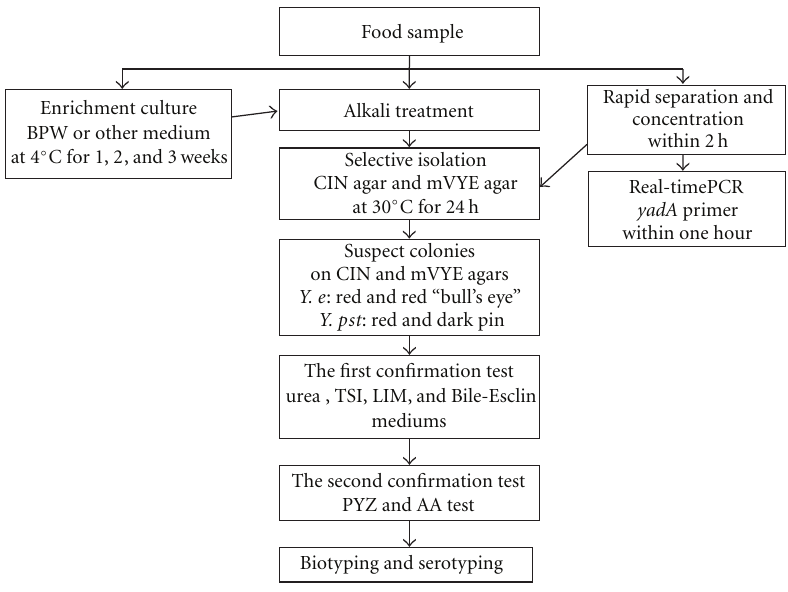
Figure 1: Optimal protocol for detection and identification of Y. enterocolitica and Y. pseudotuberculosis from foods.